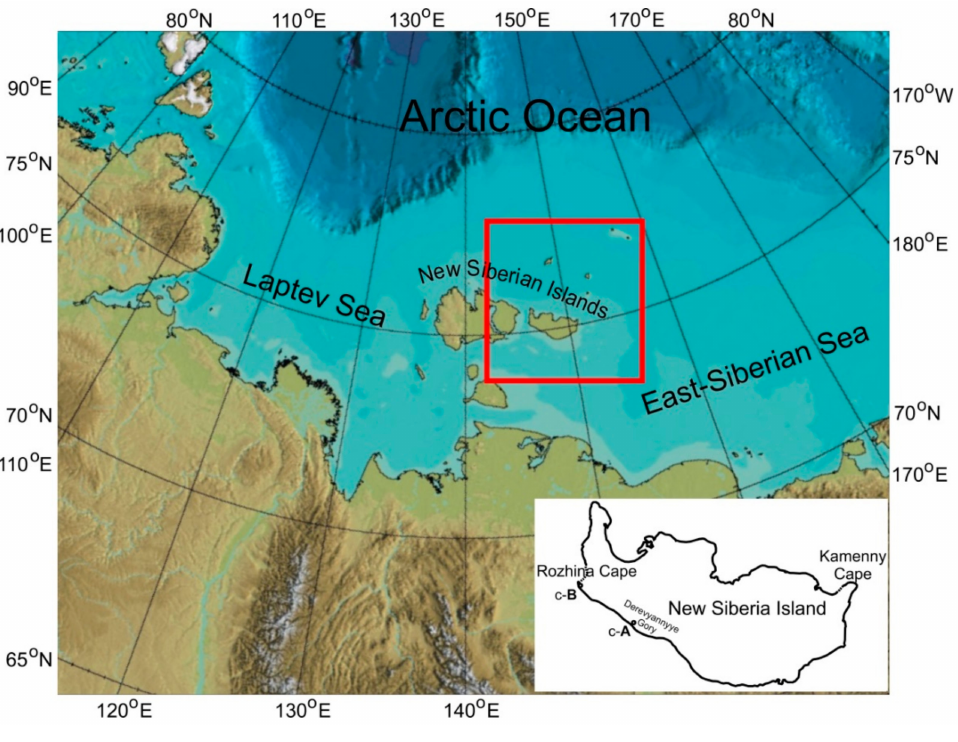
Figure 1. Study area.